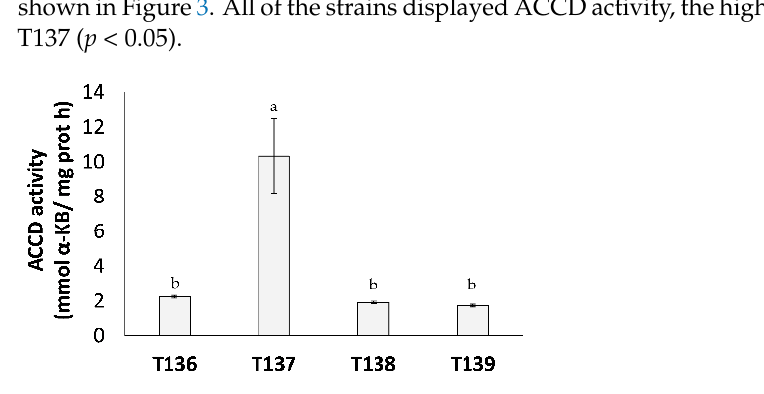
Figure 3. The 1-aminocyclopropane-1-carboxylic acid deaminase (ACCD) activity of four Trichoderma strains ( T. harzianum T136, T. simmonsii T137, T. afroharzianum T138, and T. harzianum T139), expressed as millimoles of α -ketobutyrate in 1 h per milligram of protein, in a four day synthetic medium culture. The data were calculated from three replicates for each strain. Different letters above the bars indicate significant differences according to one-way analysis of variance (ANOVA) followed by Tukey’s test ( p <